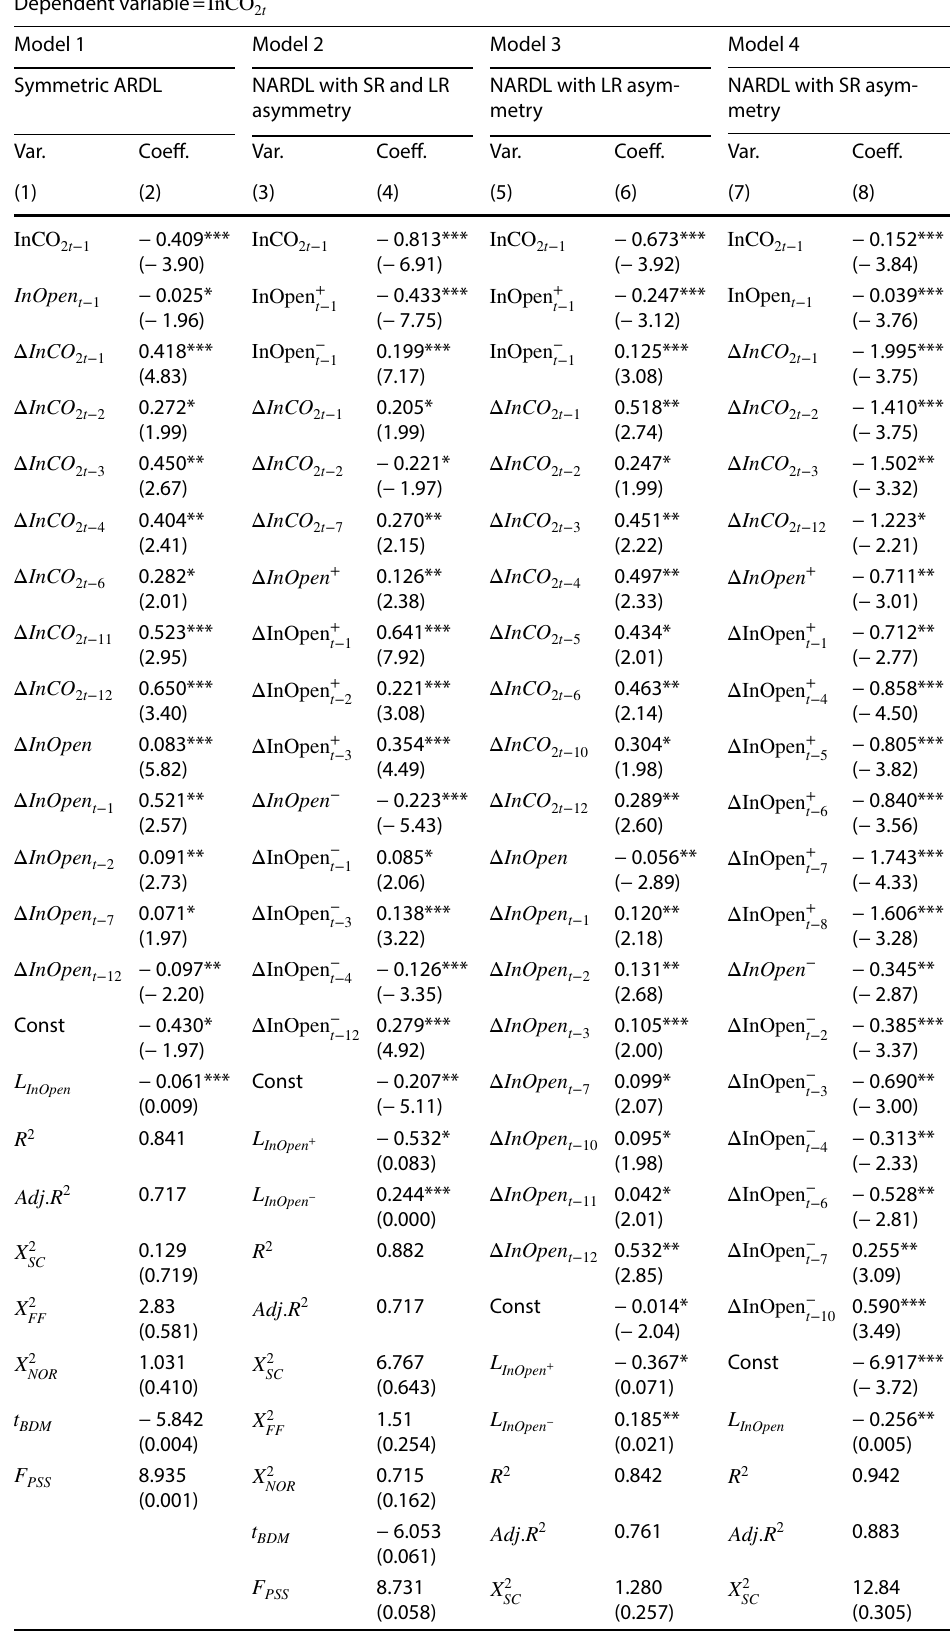
Table 13 Full-information estimates of both symmetric ARDL and nonlinear ARDL (NARDL) models in South